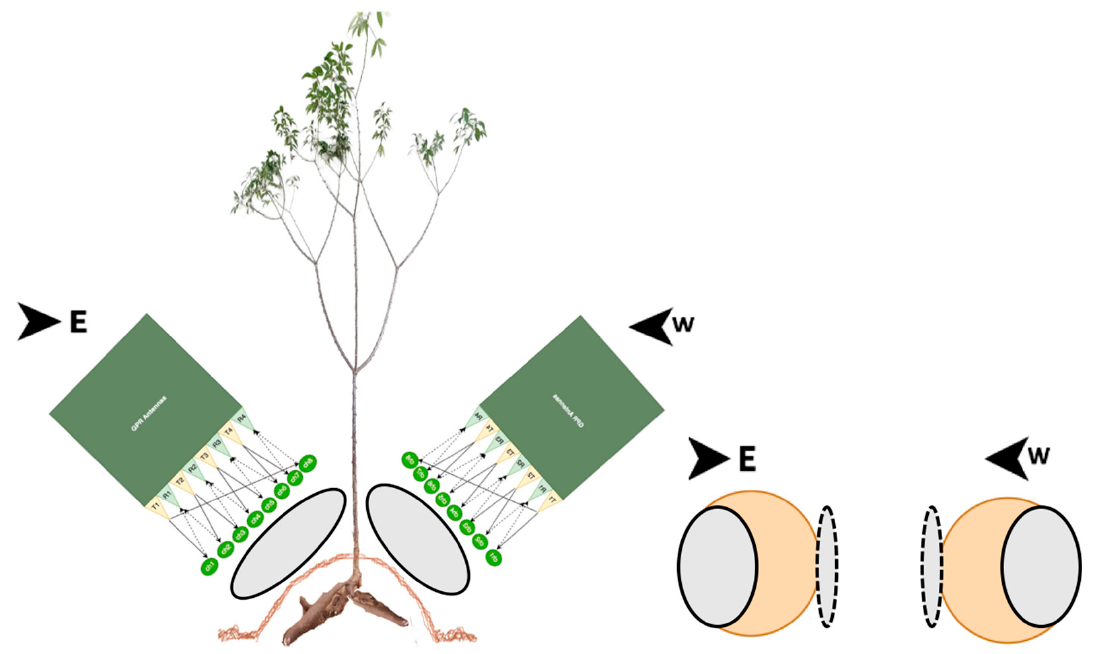
Figure 6. Fresnel zone on sample ridge on a plot row ( left ). The footprint is extended to the other side of the ridge in each transect ( right ).